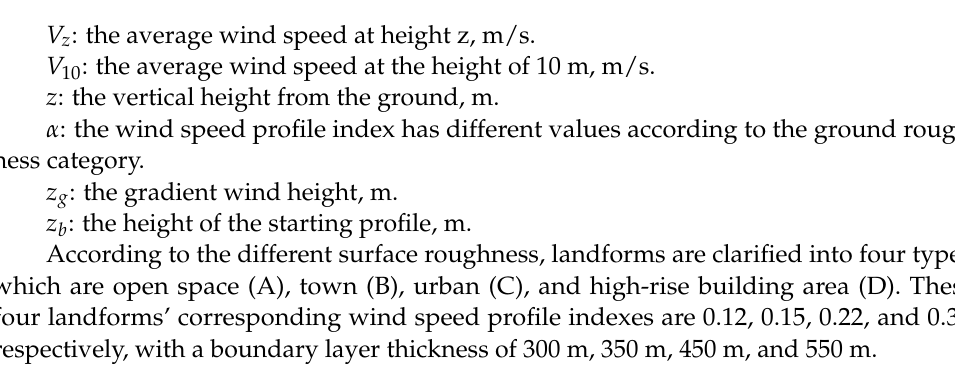
Figure 1. Schematic diagram of the gradient wind.